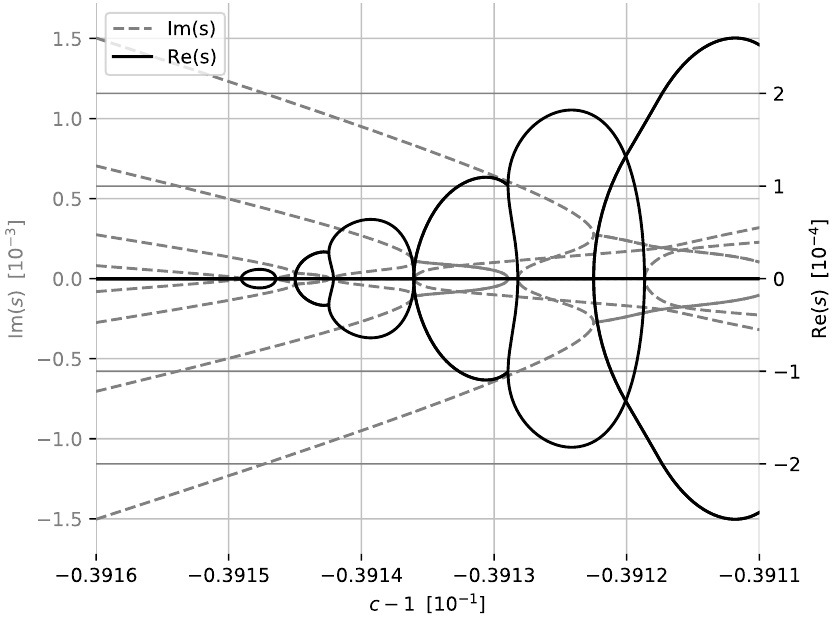
Figure 4. Stability exponent s as a function of the non-dimensional axial drive velocity c . Air mass moves with the panel, v ∞ = V 0 . Note the scale on the horizontal